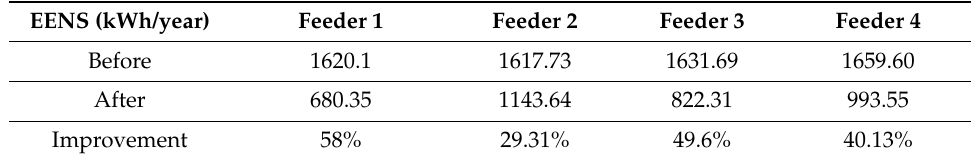
Table 7. System average interruption frequency index (SAIFI) and system average interruption duration index (SAIDI) before and after upgrading the test system. EENS: expected energy not